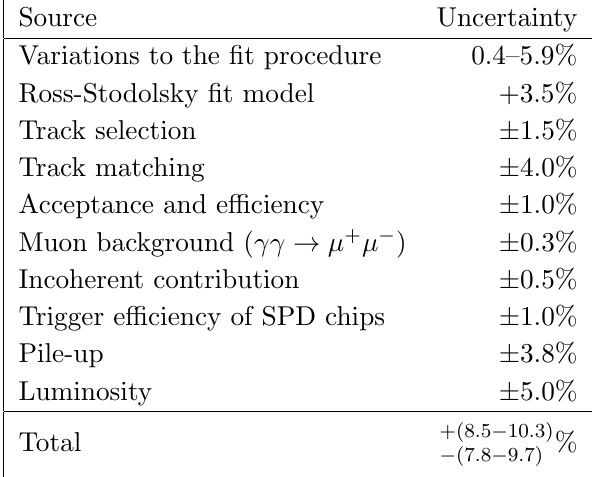
Table 1 . Summary of the systematic uncertainties. See text for details.